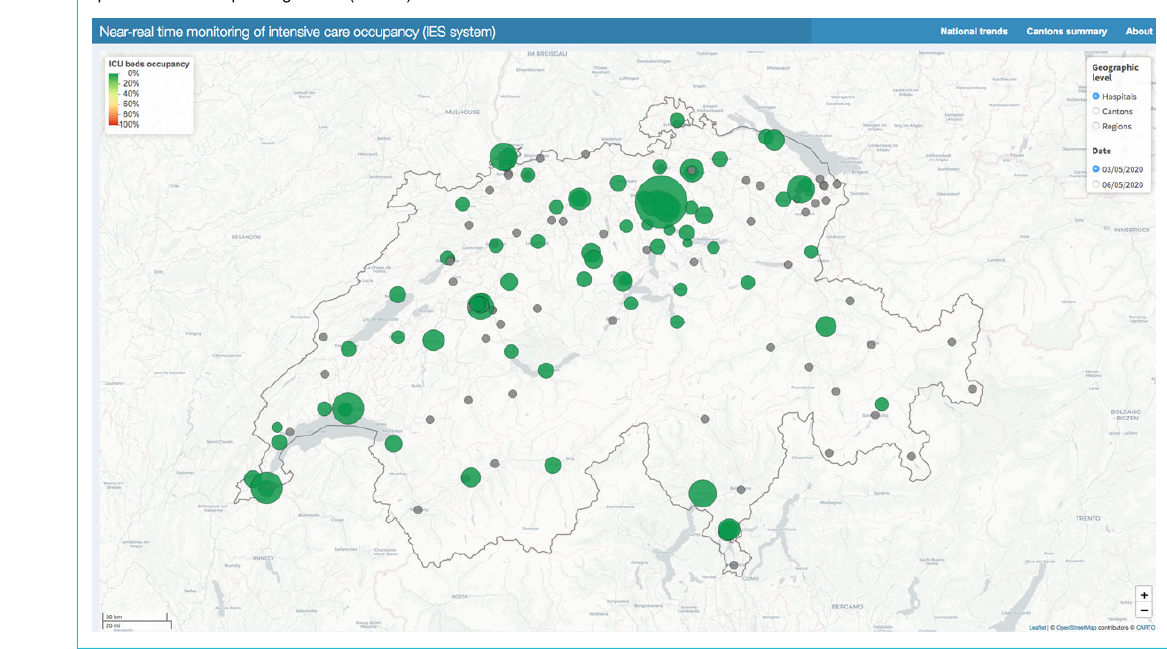
Figure 5: Hospitals with ICU (yellow), and without ICU (grey): bed occupancy in individual hospitals set to 0 artificially but available upon re- quest to the corresponding author